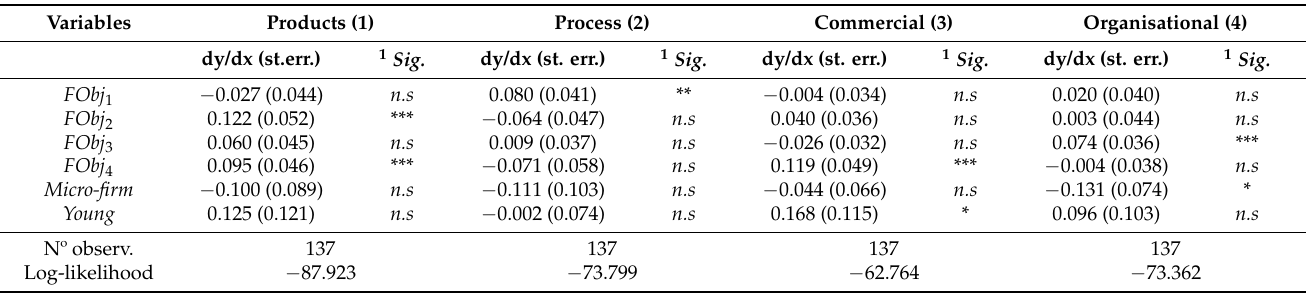
Table 9. Types of